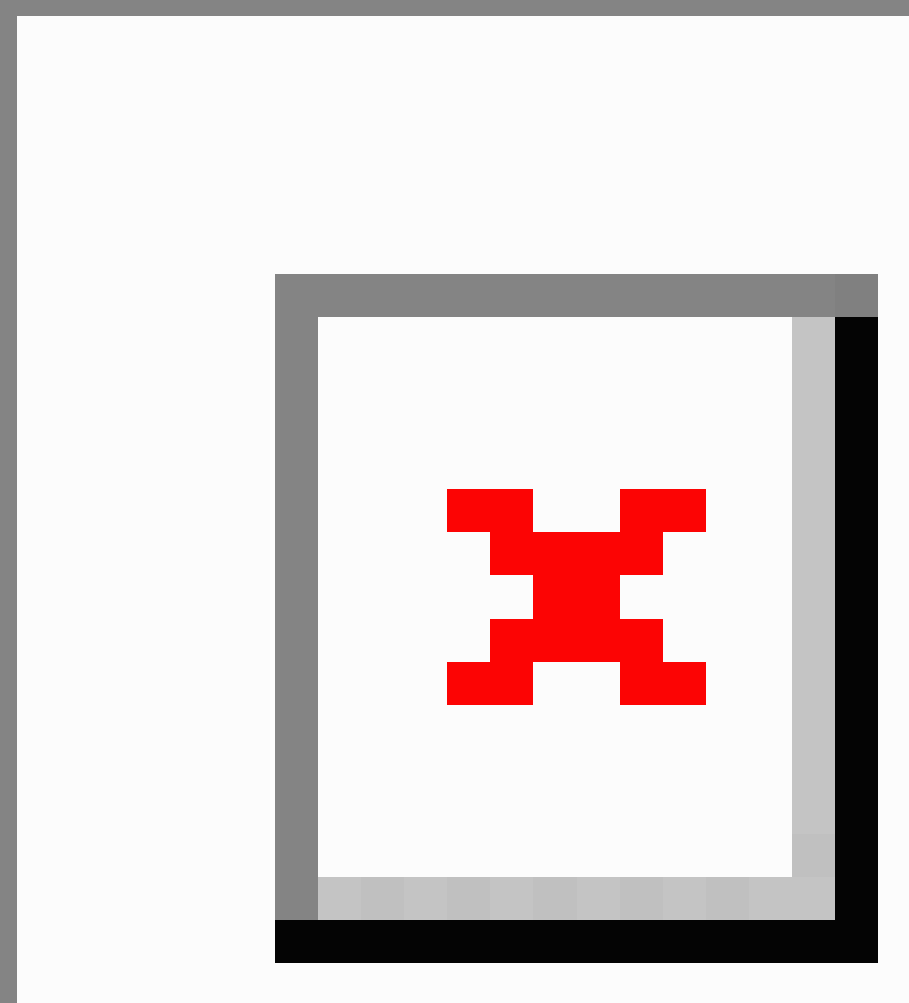
Figure 2. Screenshot of a Prezi presentation in the e-learning